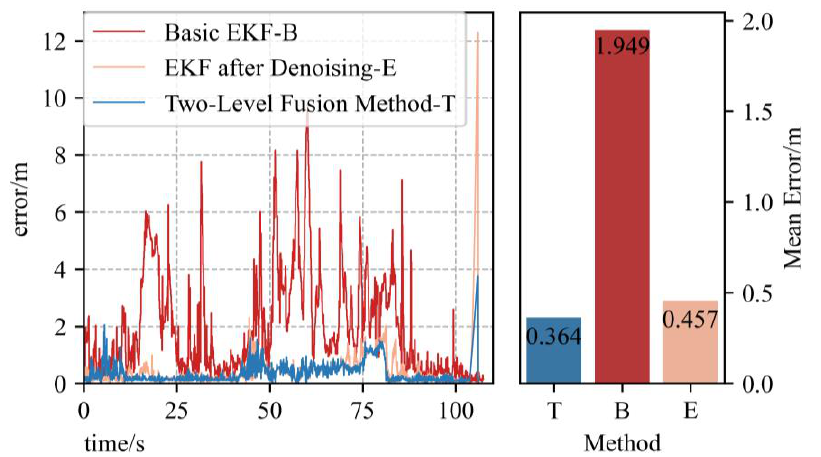
Figure 9. Error figure of all three methods, basic EKF ( “ B ” for short), EKF based on data after de- noising ( “ E ” for short) and two-level error model EKF method ( “ T ” for short). The mean errors are on the